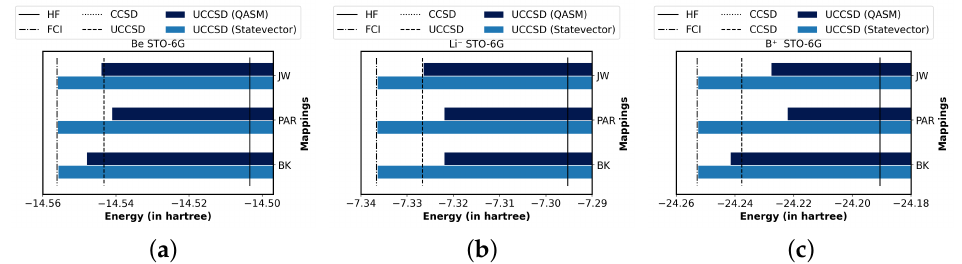
Figure 5. Figure showing bar plots depicting the values of ground state energies of the ( a ) Be, ( b ) Li − , and ( c ) B + obtained from variational quantum eigensolver calculations in the STO-6G basis, with various fermion to qubit mapping techniques, and on different backend simulators. The notations are the same as in Figure